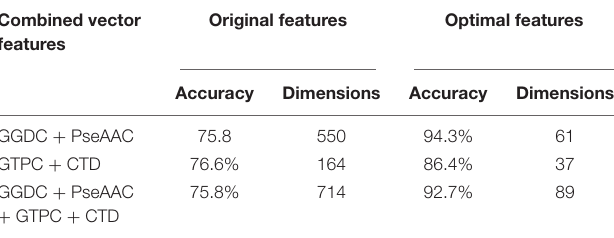
TABLE 3 | The results by using different feature for discriminating phage hydrolases from other enzymes. Combined vector features